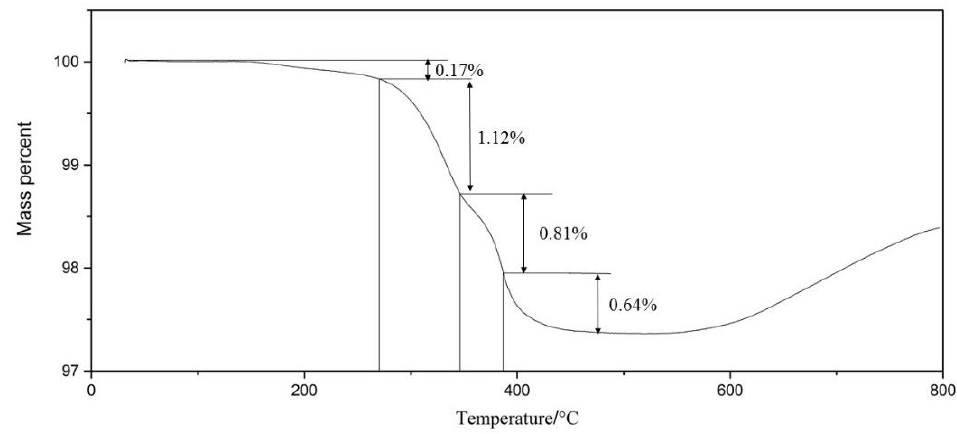
Figure 1. Thermogravimetric analysis.